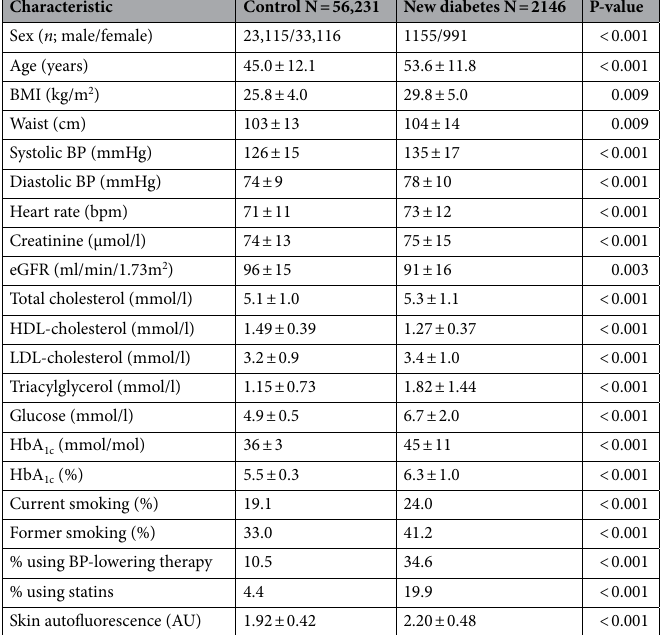
Table 1. Baseline characteristics of the participants according to follow-up diabetes status. Data are presented as numbers, percentages, or mean ± SD. BMI body mass index, BP blood pressure, eGFR estimated glomerular